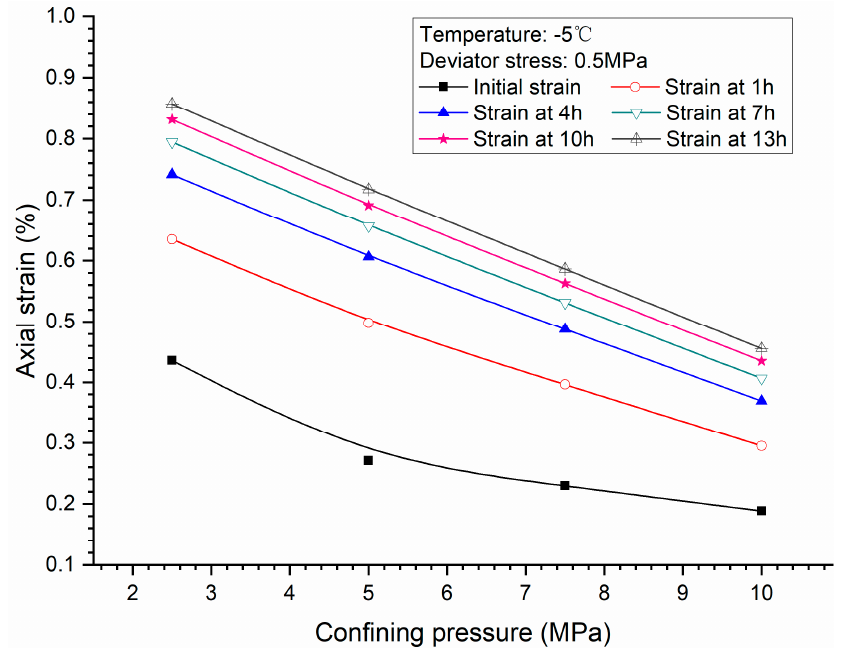
Figure 11. Initial strain and axial strains versus confining pressure for methane hydrate-bearing frozen specimens.